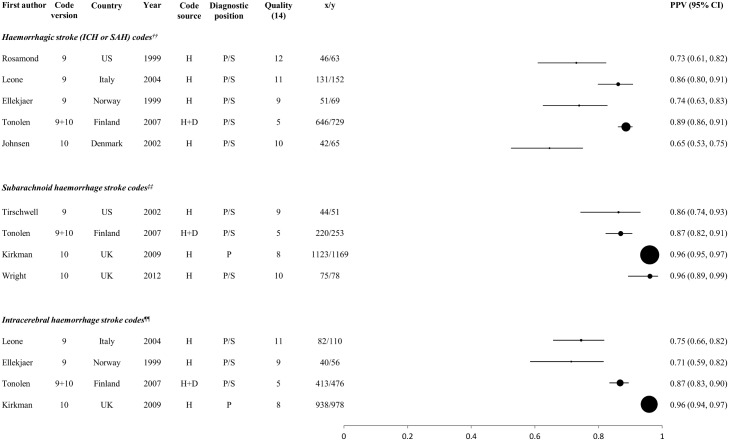
Positive predictive values of codes for haemorrhagic stroke.H: hospital data, D: death certificates, H+D: hospital data and death certificates; x = number of coded events confirmed as ‘true cases’ by the reference standard; y = total number of coded events; x/y = PPV. Circles represent PPVs, and horizontal lines denote 95% confidence intervals (CIs). Circle size is proportional to the inverse variance of the PPV. Where more than one result was available for a particular study, the result for the largest number of coded events validated is shown.† Mean PPV (taken from the range published in the study)†† Haemorrhagic stroke codes:I60, I61 (ICD-10), 430, 431 (ICD-9)‡‡ Subarachnoid haemorrhage stroke codes:I60 (ICD-10), 430 (ICD-9)¶¶ Intracerebral haemorrhage stroke codes:I61 (ICD-10), 431 (ICD-9)